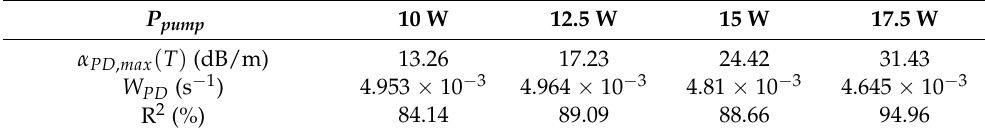
Figure 13. The curve of additional loss with time under different power levels.